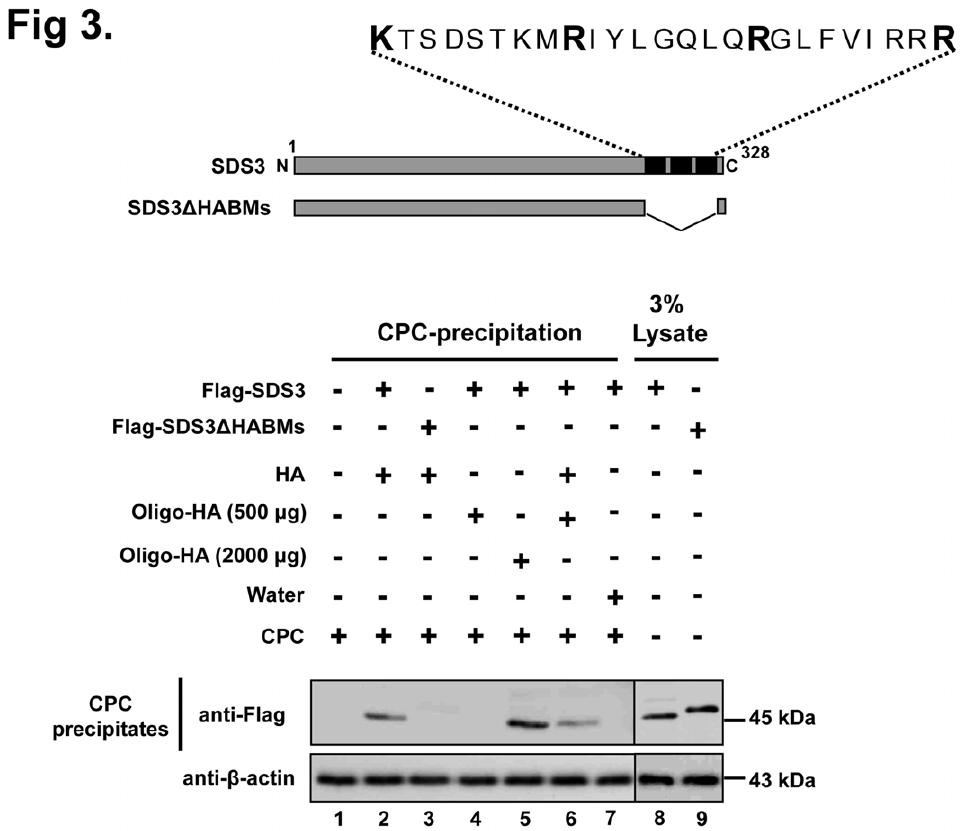
Figure 3. Hyaluronan binding activity of SDS3. Cell lysate aliquots from 293 T cells transfected with SDS3 and HABM-deleted construct of SDS3 were incubated with HA and different concentration of HA oligosaccharides, and subjected to CPC precipitation followed by Western blot analysis with an anti-Flag antibody.